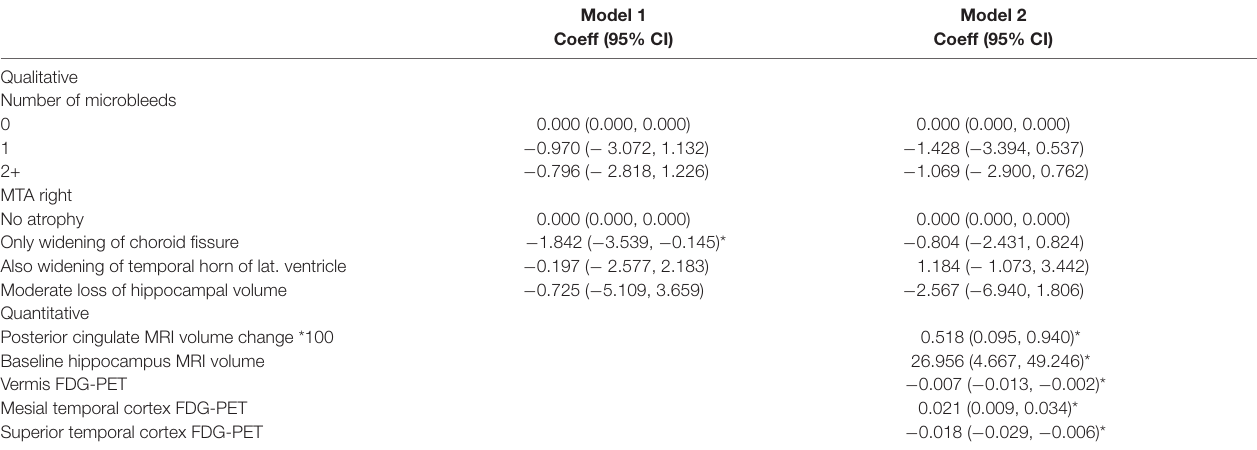
TABLE 3 | Continuous cognitive score difference explained by multiple linear regressions with qualitative (Model 1) vs. qualitative plus quantitative (Model 2) imaging